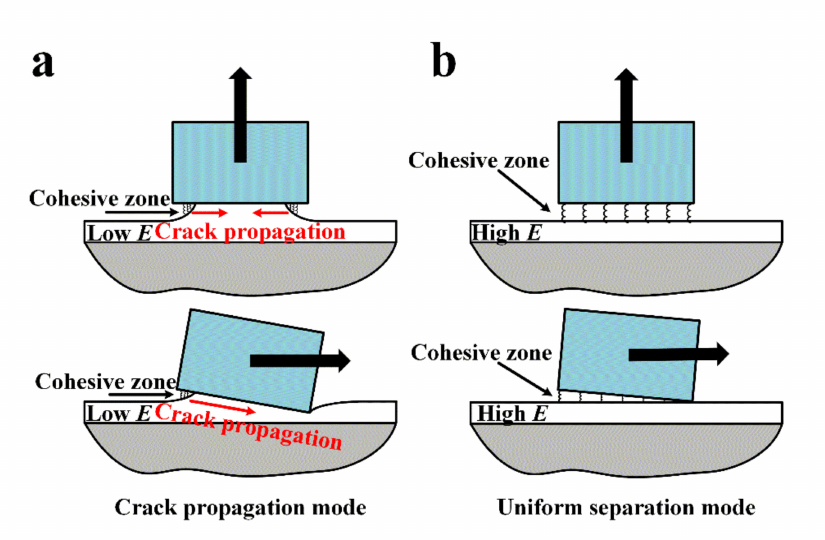
Figure 10. Schematic diagram of ( a ) crack propagation mode for a small E and ( b ) uniform separation mode for a large